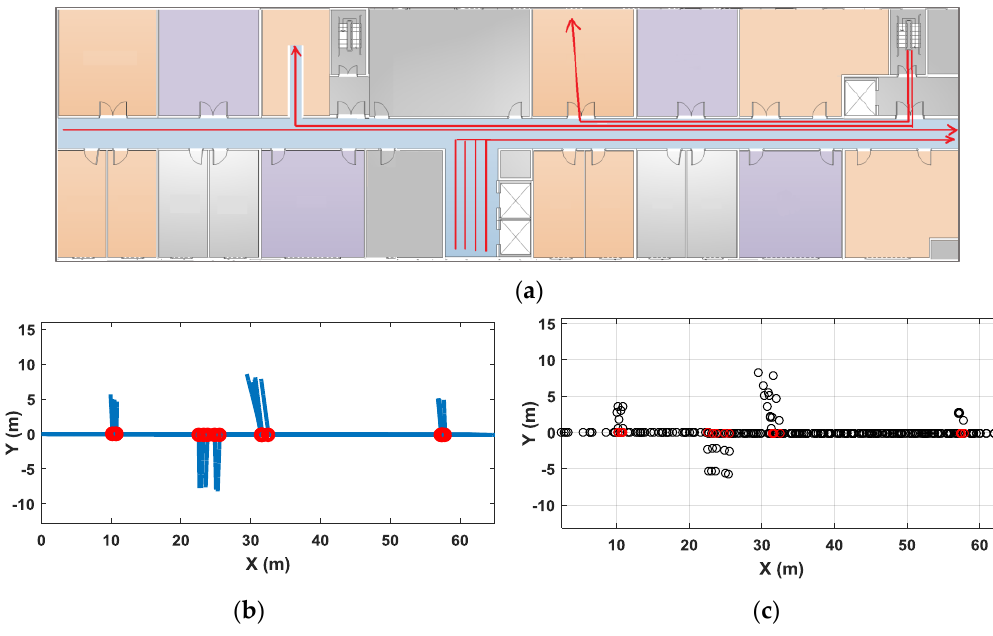
Figure 22. Experiment results in an office floor: ( a ) floor plan and examples for test traces; ( b ) final pathway map constructed by proposed method; ( c ) labeled Wi-Fi sample points using the constructed pathway map.